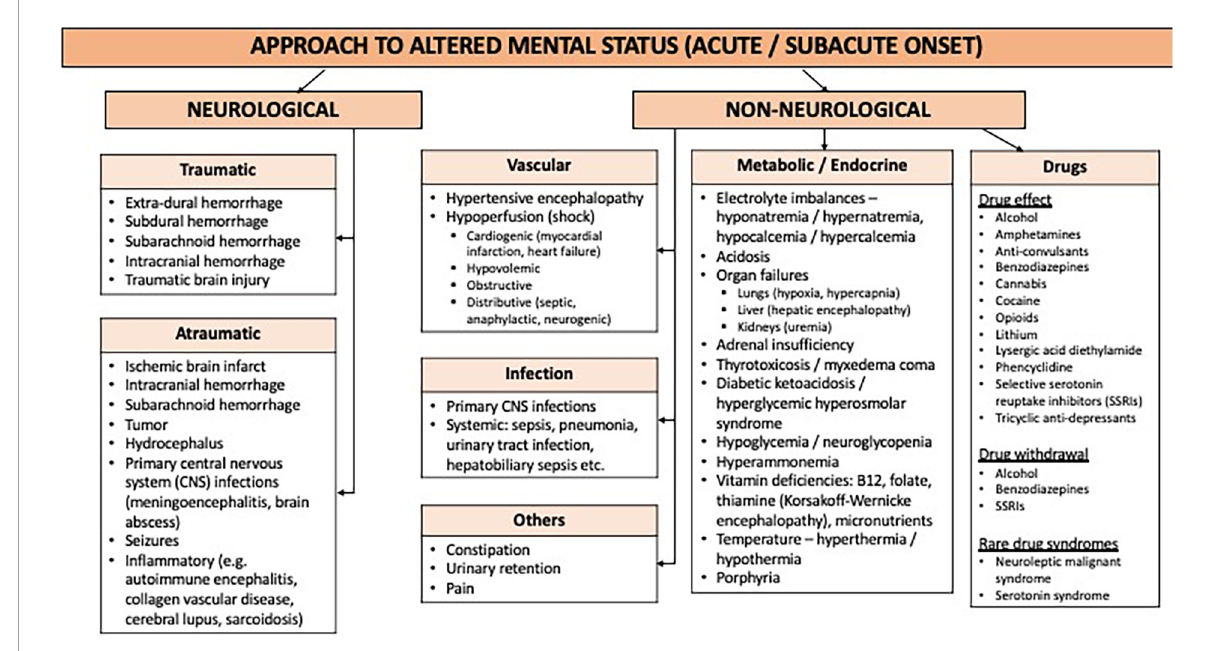
FIGURE1 Approach to altered mental status (AMS) (acute and subacute